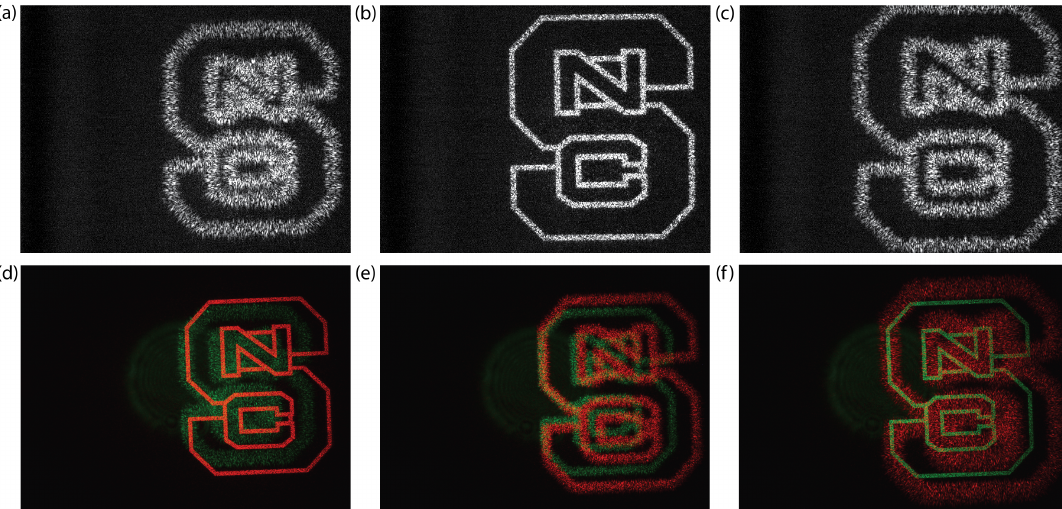
Figure 5. Measured monochromatic replay images by a CCD for a 633-nm laser illumination with desired polarization input of ( a ) z = 4.5 cm, ( b ) z = 5 cm and ( c ) z = 5.5 cm. Captured colored replay images by a camera for a 633-nm and a 532-nm laser illumination with desired polarization input of ( d ) z = 7.5 cm, ( e ) z = 8.3 cm and ( f ) z = 8.9